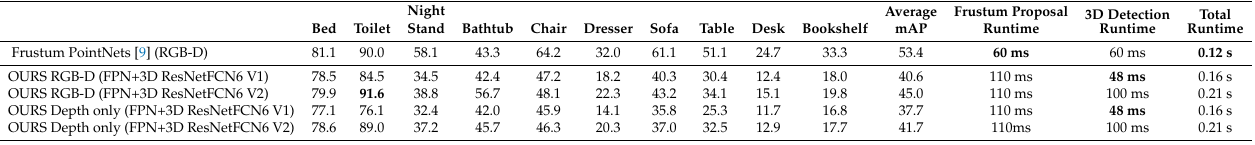
Table 10. 3D detection results on SUN RGB-D validation set. Evaluation metric is average precision with IoU threshold of 0.25 as proposed by [7]. Average mAP is used to have an overall comparison.